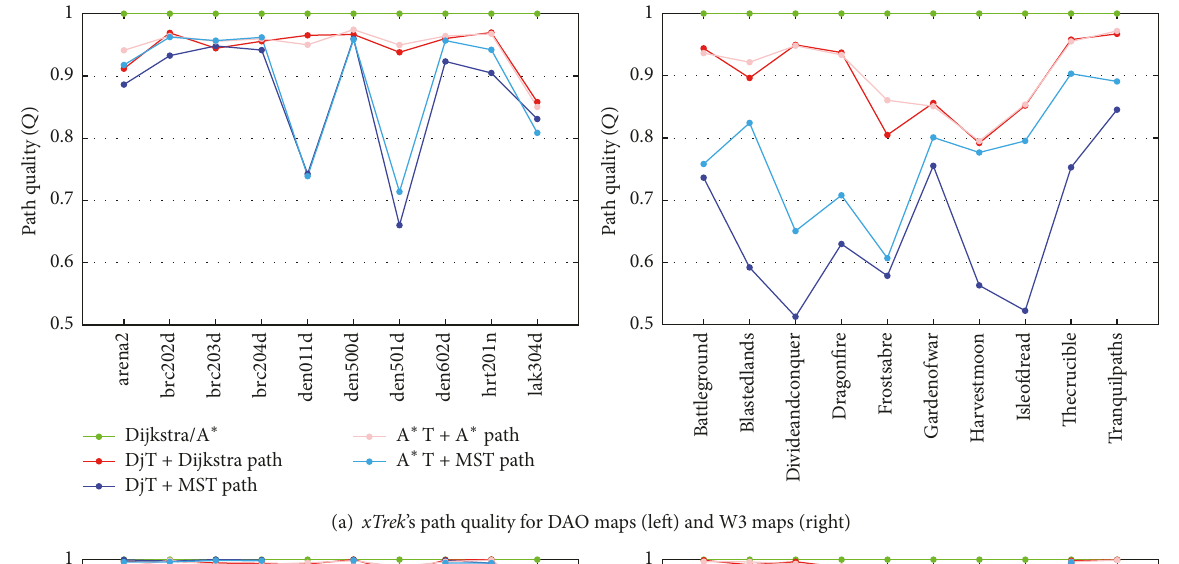
(a) xTrek ’s path quality for DAO maps (left) and W3 maps (right)